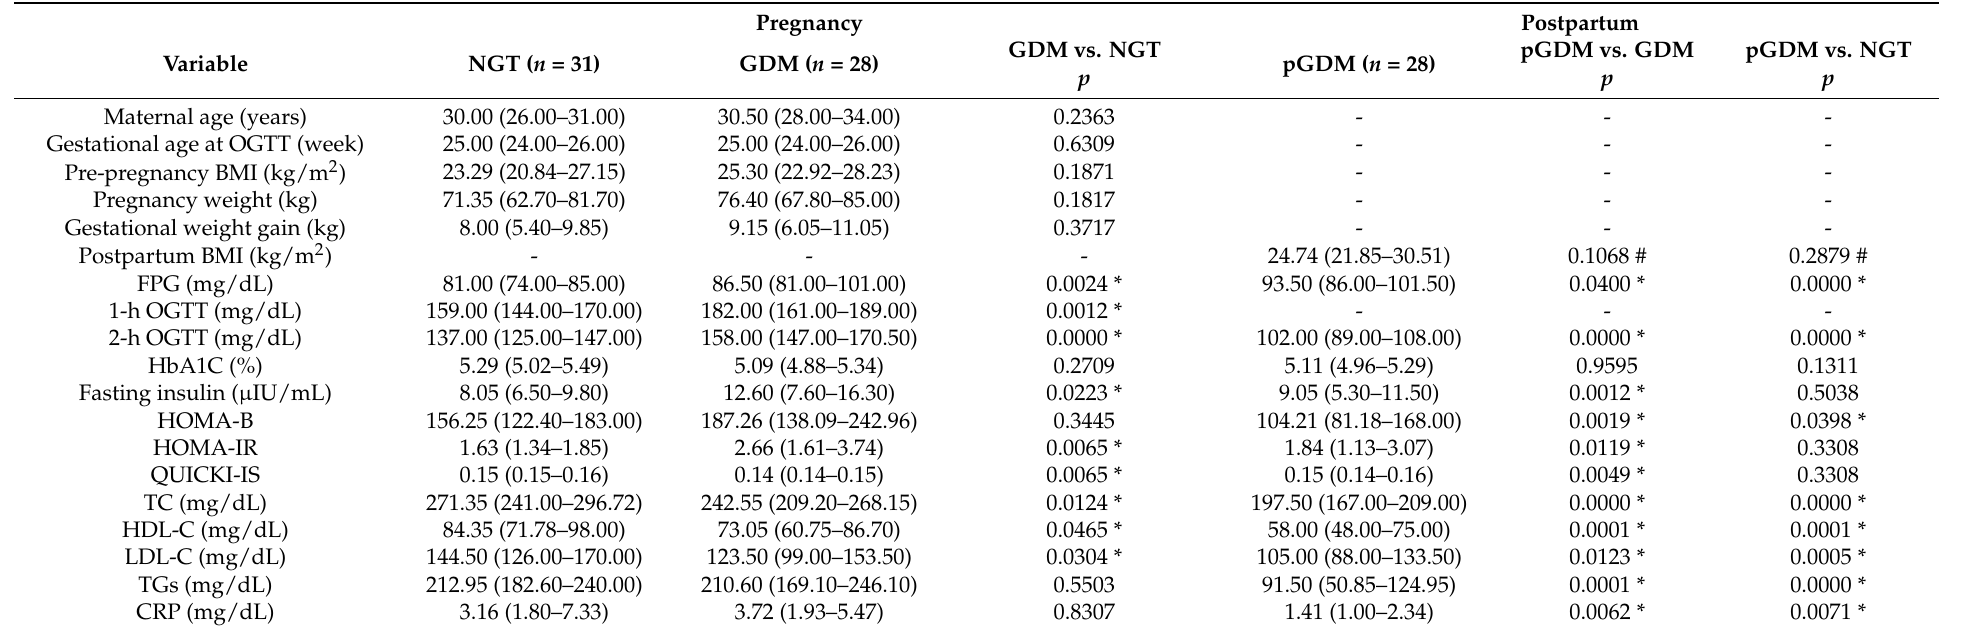
Table 1. Baseline characteristics of the study